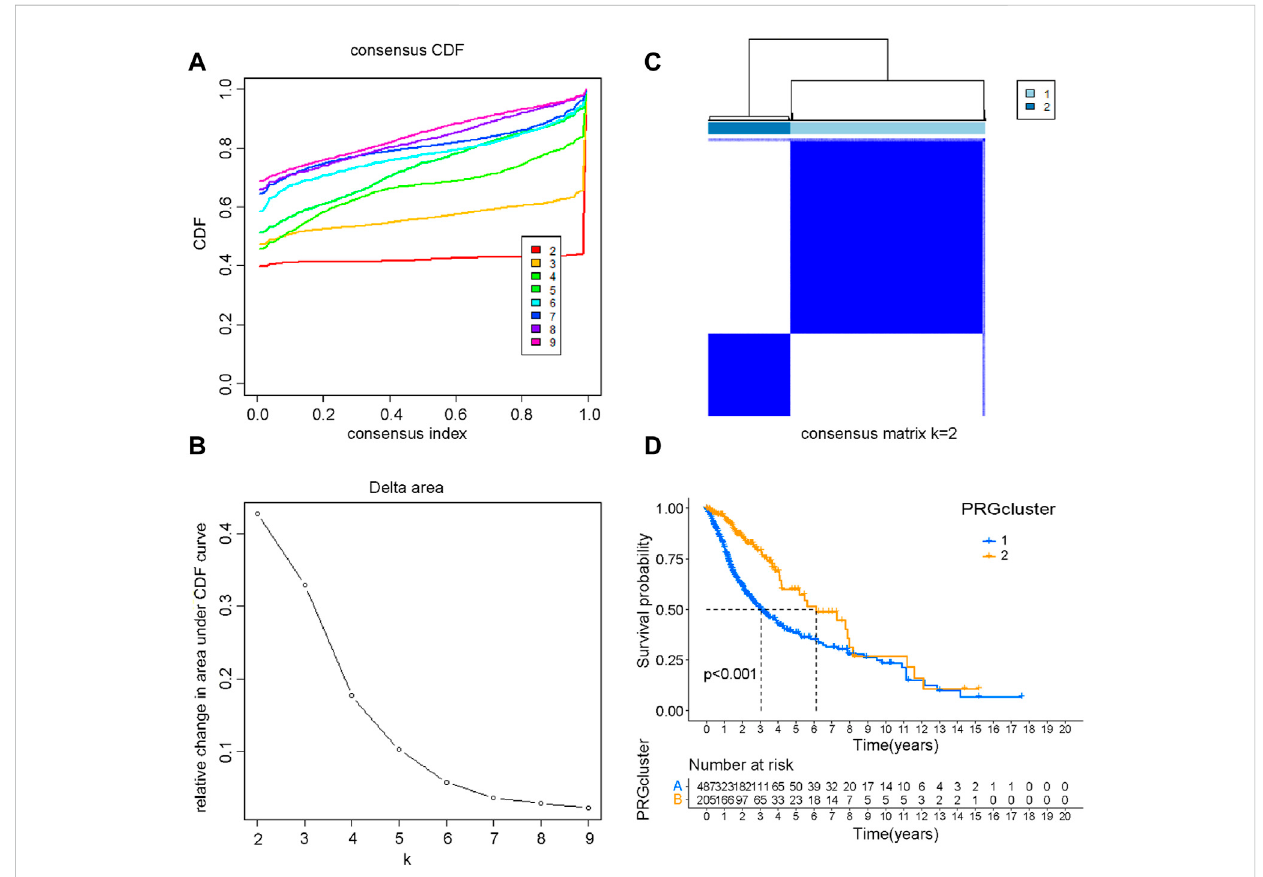
FIGURE 2 ConsensusclusteringofPRGs. (A) TheempiricalCDFplotwith k =2 – 9. (B) TheCDFAUCwith k =2 – 9. (C) Consensusclusteringmatrixwith k =2. (D) The Kaplan-Meier survival curve of glioma patients in the cluster 1 and cluster